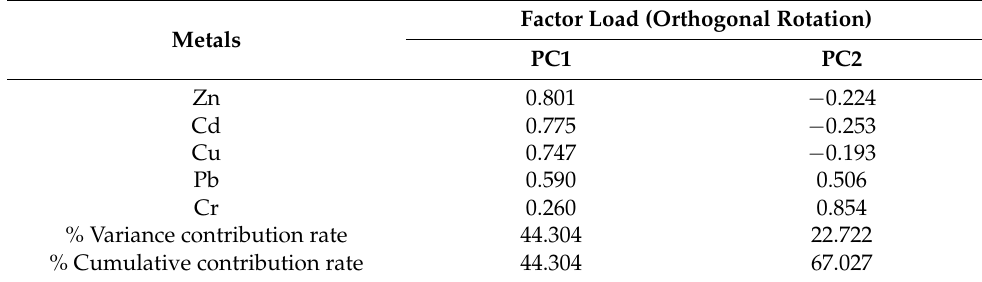
Table 8. Results of principal component analysis (PCA).